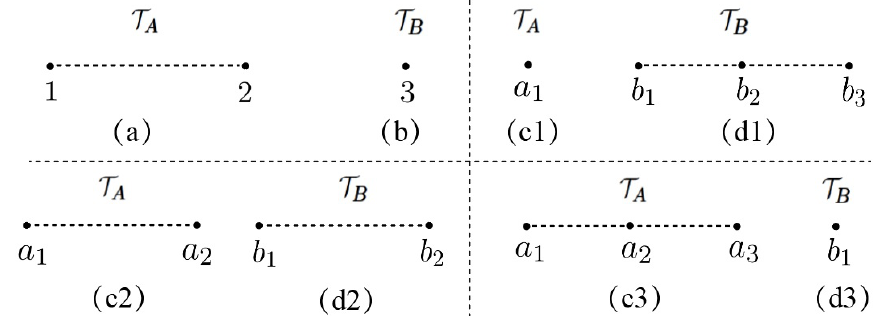
Figure 2 . In the relation for Berends-Giele currents with three external particles, if T AAA involves two nodes and T has a single node, the possible structures of the graphs can only be (a) and (b). Per- BBB mutations established by these graphs are T graphs for the relation with four external particles are given by (c1), (d1), (c2), (d2) and (c3), (d3).